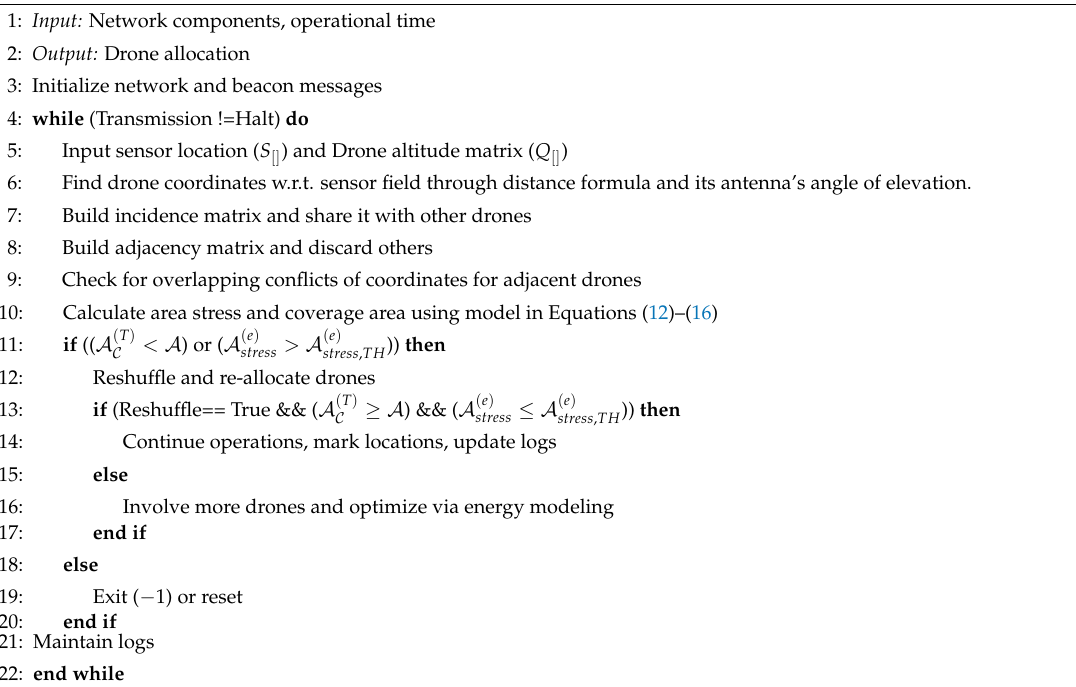
Algorithm 1 Location Identification and Coverage